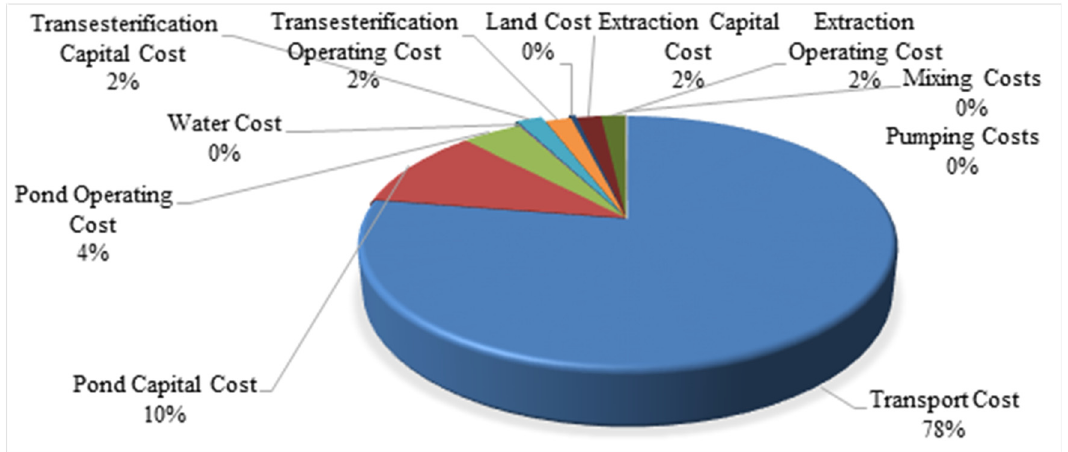
Figure 18. Cost associated with the United States biomass to biodiesel supply chain network problem.